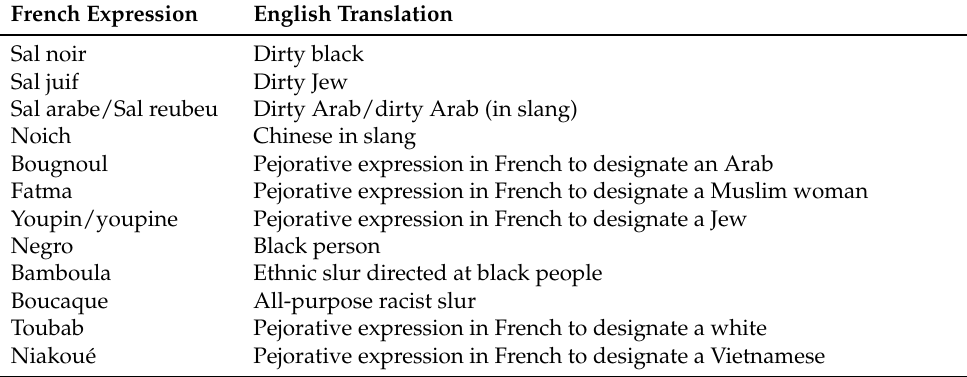
Table 1. French racist term